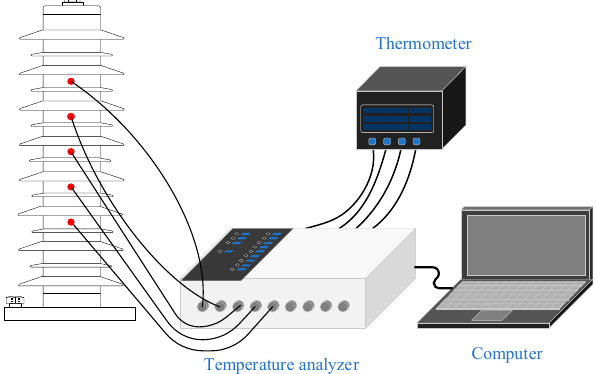
Figure 3. Fluorescent optical fiber temperature measuring system.